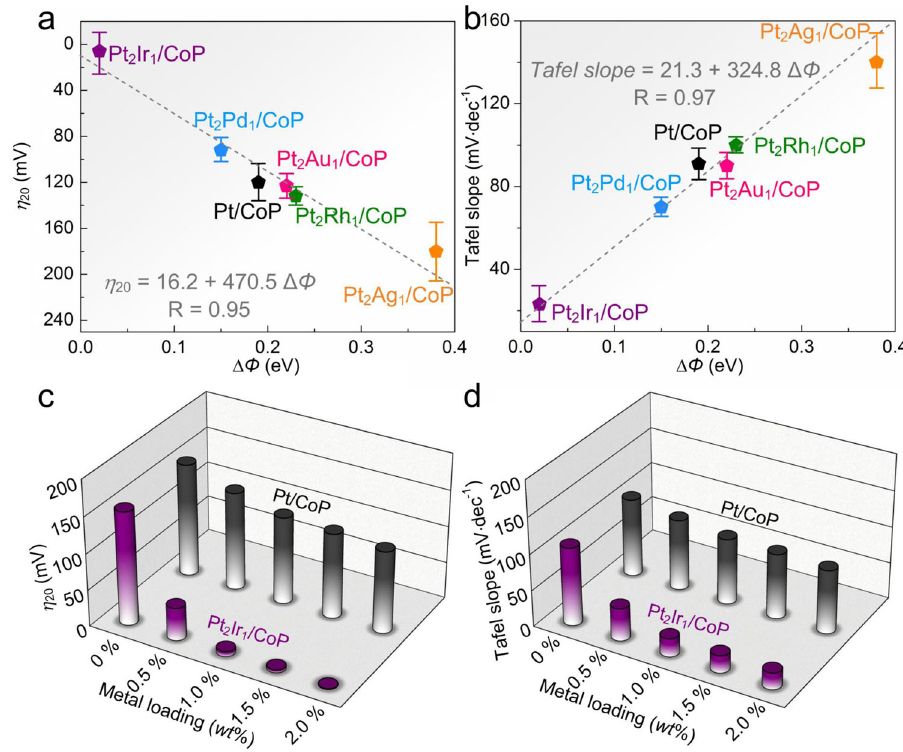
Fig. 5 Correlation with intrinsic HER activity of various PtM/CoP model catalysts and their Δ Φ . a HER activity trends of η 20 as a function of the Δ Φ . b Plots of LSV – derived Tafel slope values as a function of the Δ Φ . Error bars stand for the standard deviation of three independent HER measurements. Comparisons of η 20 ( c ) and Tafel slope ( d ) of Pt 2 Ir 1 /CoP paradigm with Pt/CoP as positive control catalysts at each metal